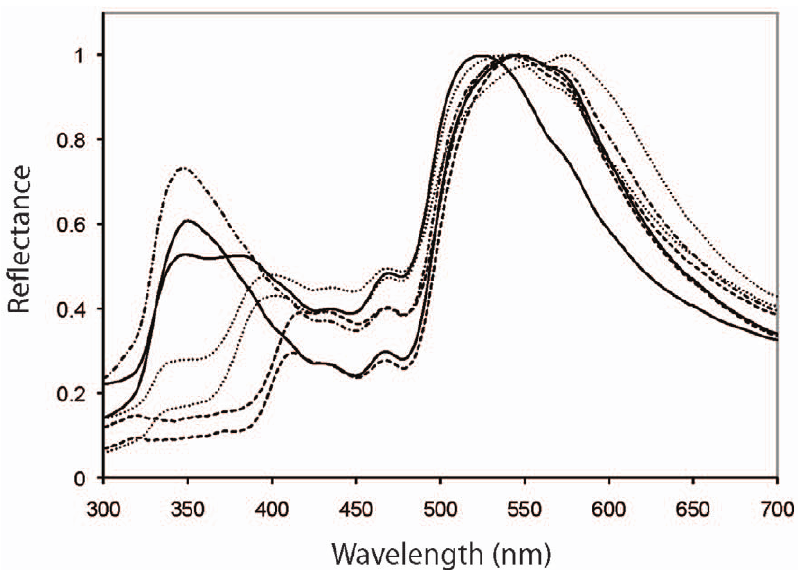
Figure 1. UV/VIS spectral reflectance from sand lizard flanks: wild (long-short dash), control-manipulated (solid lines), UV-manipulated 1 hour (dash), and 30 days (points) after treatment. Note the considerable UV-reduction also after 30 days in the wild. Spectra are set to equal brightness, in order to see spectral shape (i.e., colour) more precisely.